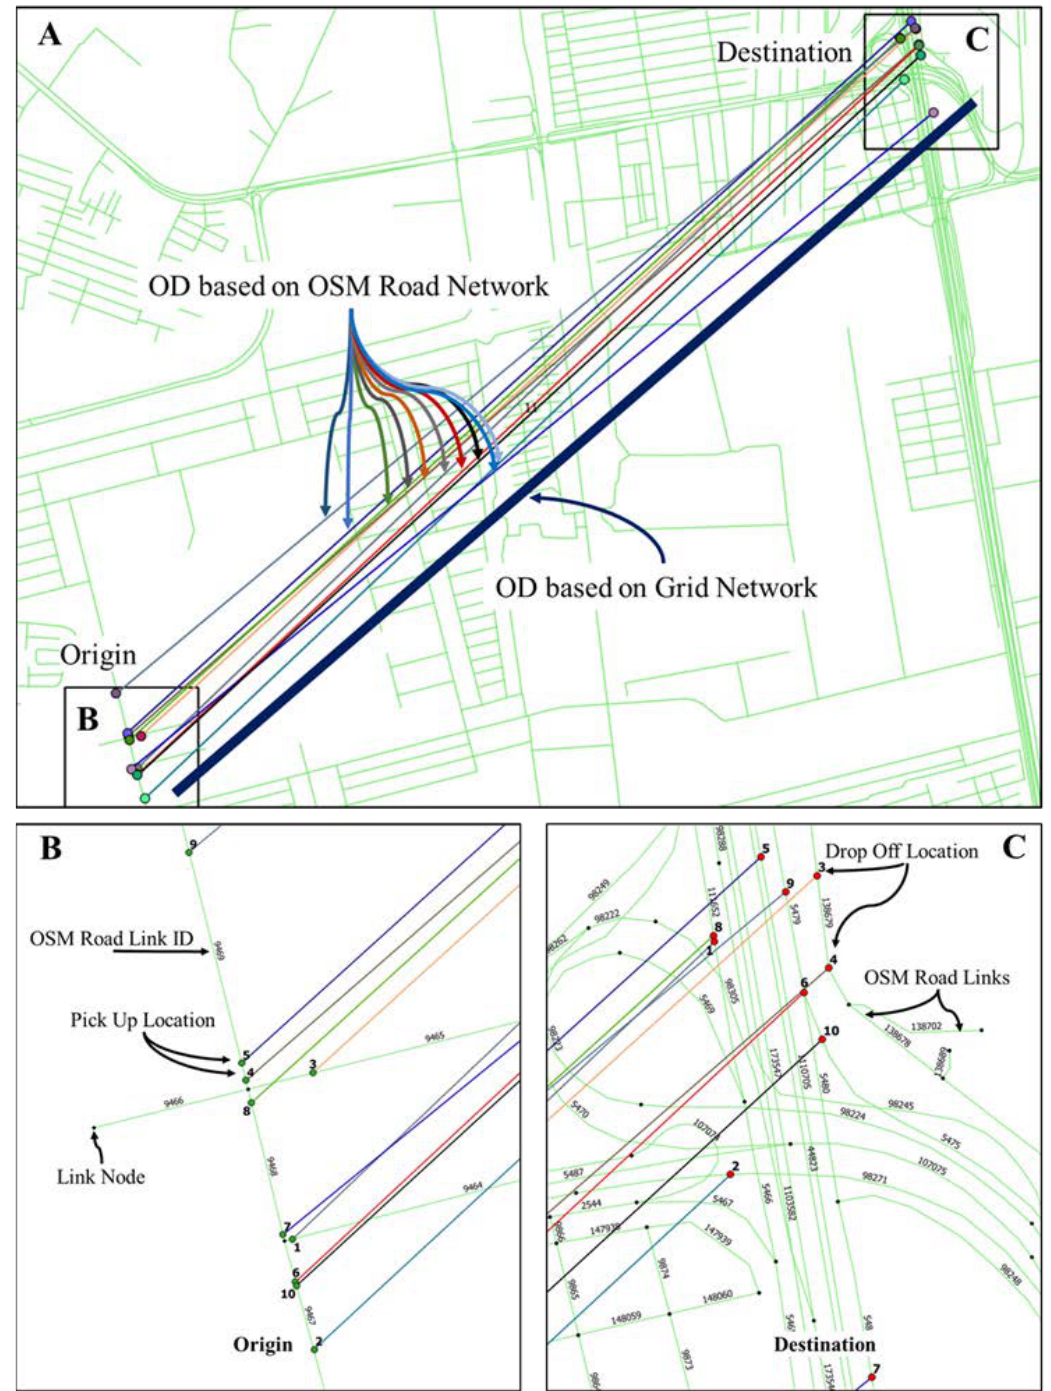
Figure 8. ( A ) OSM road network and grid network OD comparison; ( B ) Pick-up location at origin with respect to OSM road network; ( C ) Drop-off location at destination with respect to OSM road network.